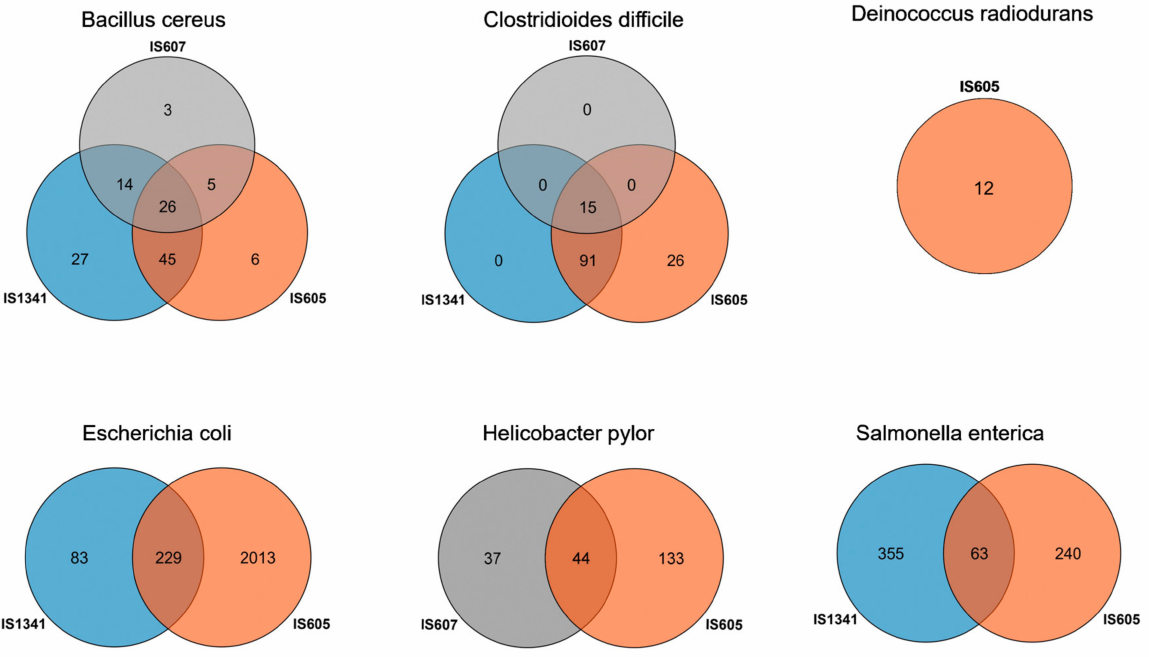
Figure 5. The genome number of different TCME groups in six species. The IS607 is shown in grey color, IS605 is shown in orange color, and the color blue represents IS1341